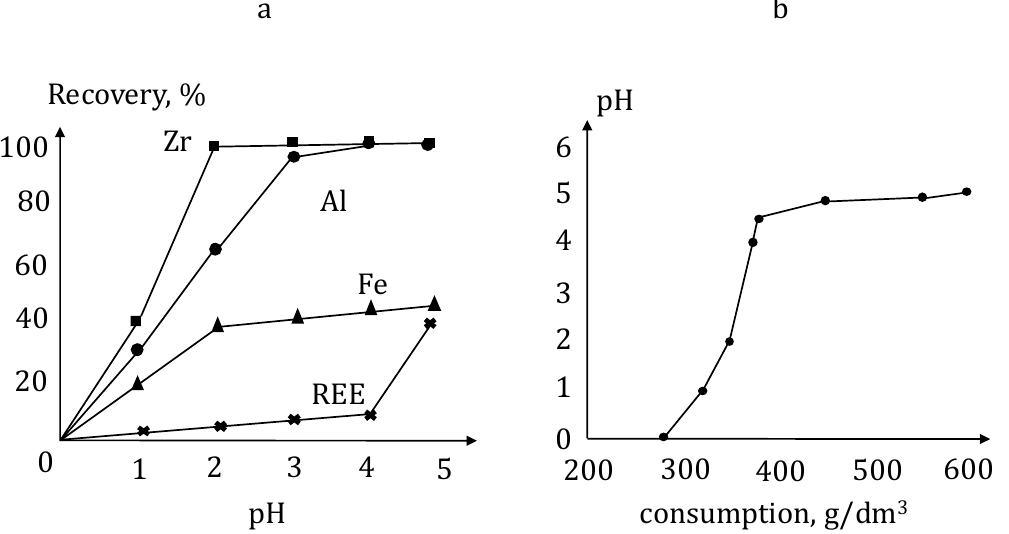
Figure 8. Effect of solution pH on elements’ recovery into the solid precipitate ( a ), and the correlation of CaC О 3 consumption and pH solution at 20 °C ( b ).